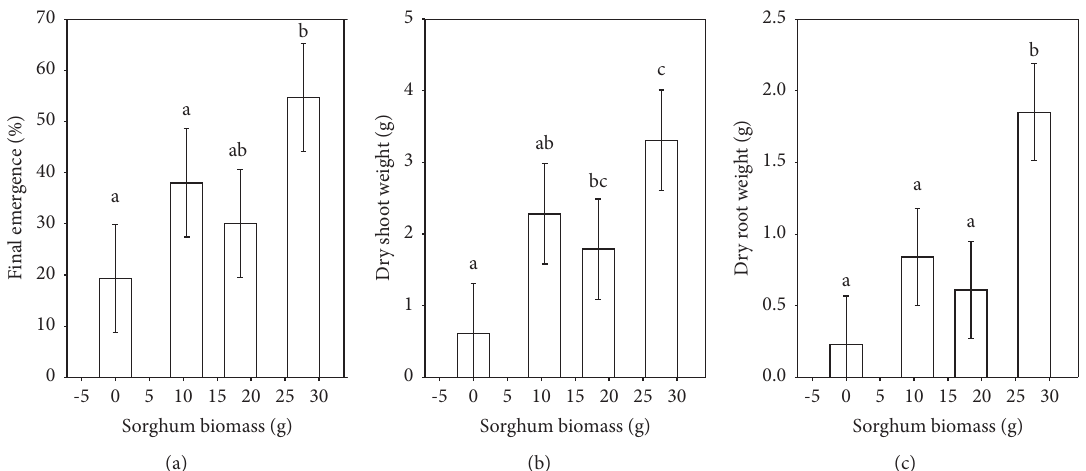
Figure 2: Effect of ground sorghum biomass on (a) the final emergence, (b) shoot dry weight, and (c) root dry weight (c) of goose grass. Bars indicated with different letters show that there was a significant ( p < 0 . 05 ) differences between treatments. Error bars represent LSD at p < 0 . 05.